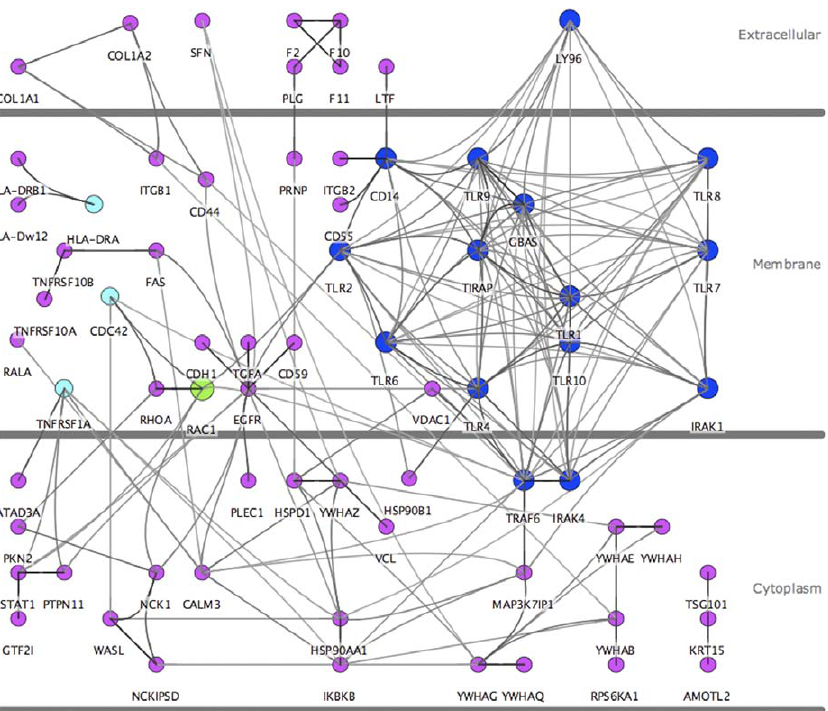
Figure 2. Human Proteins Interacting with Bacterial Pathogen Groups The network of interactions between human proteins interacting with at least one bacterial pathogen group. The size and color of a protein denote the number of pathogen groups that interact with it: purple is one, light blue is two, dark blue is three, and green is four.